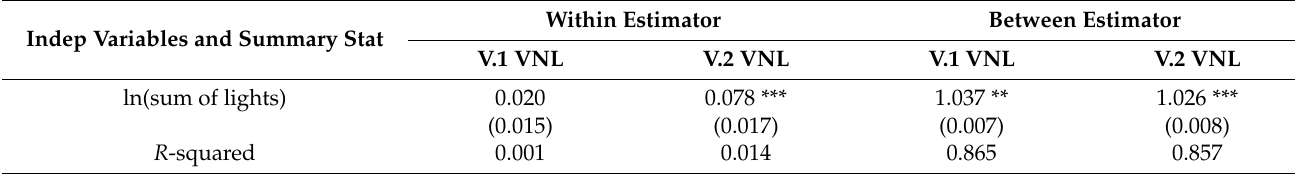
Table 4. Within and between estimators of GDP-lights elasticities: V.1 and V.2 VNL county-level results, 2015–16. Within Indep Variables and Summary Stat